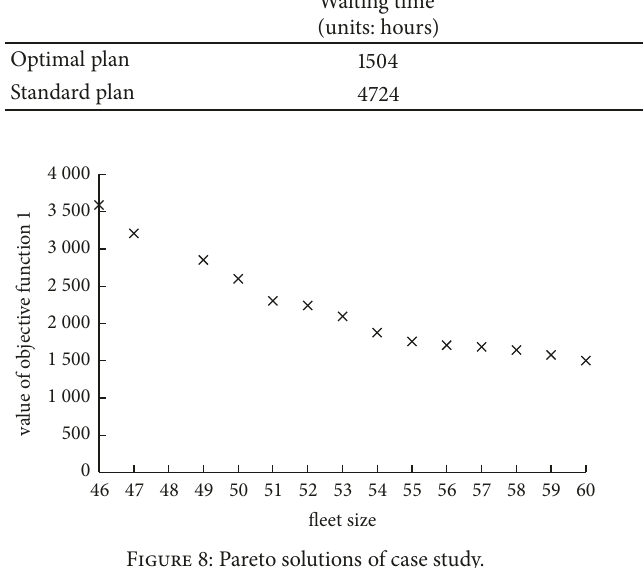
Figure 8: Pareto solutions of case study.